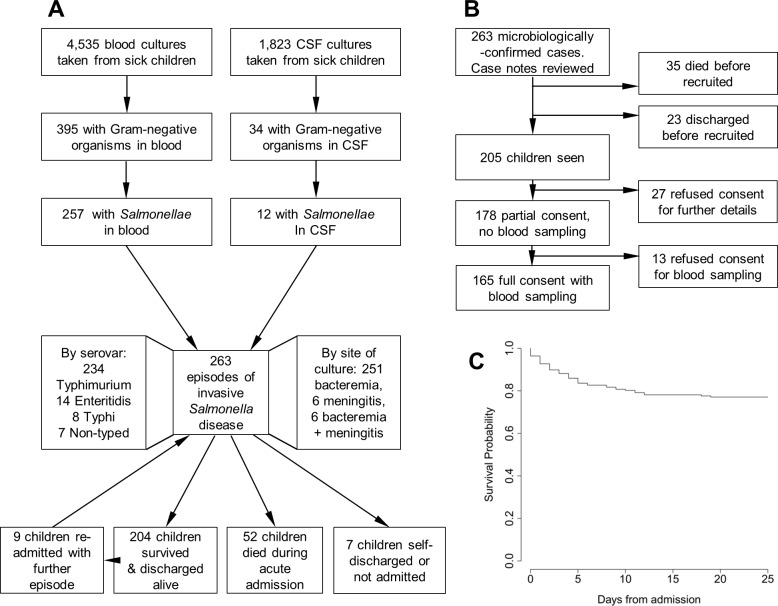
Malawian children admitted to hospital with invasive Salmonella disease, recruitment and outcomes.(A) Blood and CSF cultures taken from children admitted to Queen Elizabeth Central Hospital, Blantyre, Malawi in 2006; those yielding Salmonella isolates; and outcomes of children with invasive Salmonella disease. (B) Recruitment pathway for children following detection of Gram-negative bacteria in blood and/or CSF culture. (C) Kaplan-Meier estimate of survival (in days) of children following admission with invasive Salmonella disease.